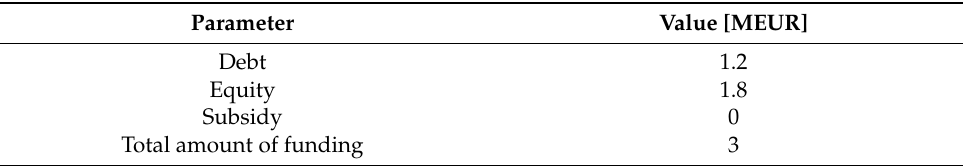
Table 7. Summary of sources of funding for total installed